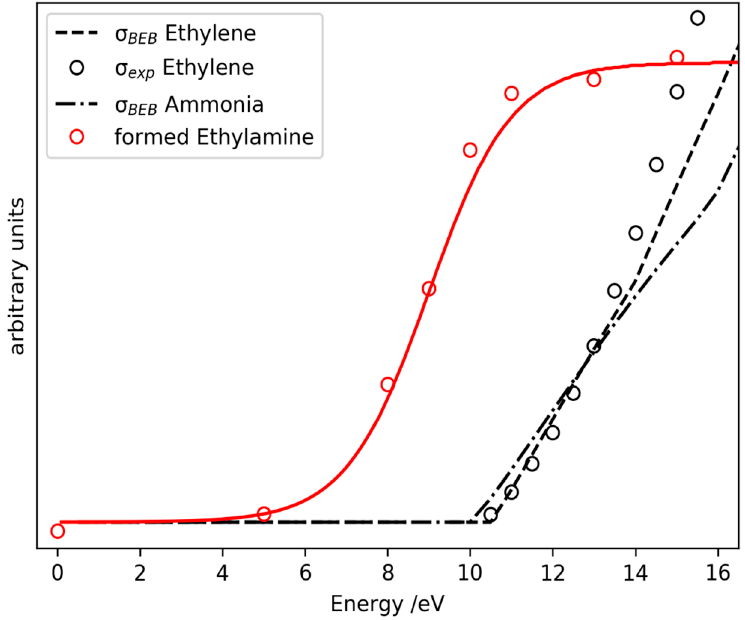
Figure 1. Predicted (black lines) electron impact cross-sections for ethylene and ammonia. Experimental cross-sections for ethylene (black open circles) are taken from Rapp and Englander-Golden [10]. The amount of ethylamine actually formed by electron irradiation of a 1:1 mixture of ammonia and ethylene is shown in red circles. The red line only serves as guide to the eye. Experimental data taken from Böhler et al. [11].